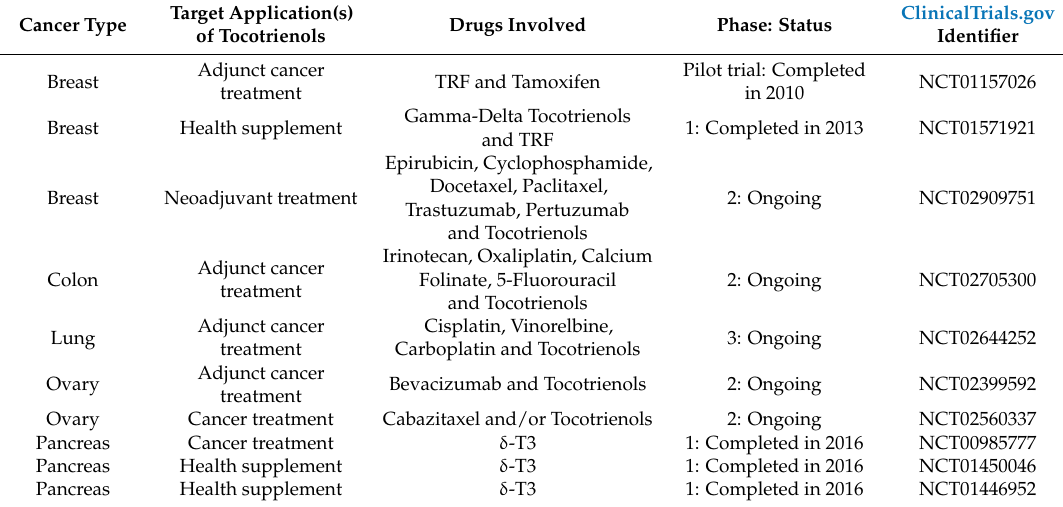
Table 3. Recent clinical trials conducted using tocotrienols for various cancer